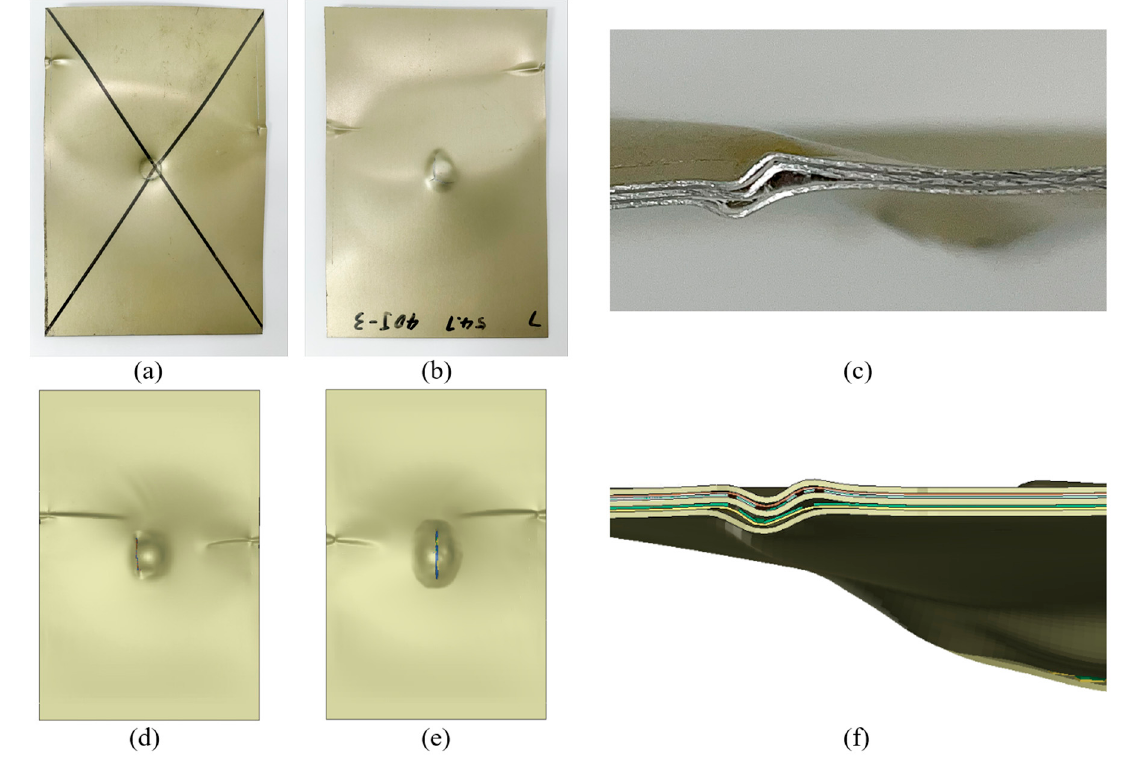
Figure 16. Experimental and numerically predicted CAI failure modes of GLARE: ( a ) impacted side; ( b ) unimpacted side; ( c ) detailed side view of failure; ( d ) numerical simulation of the impacted side; ( e ) numerical simulation of the unimpacted side; ( f ) side view of failure region simulated numeri- cally.